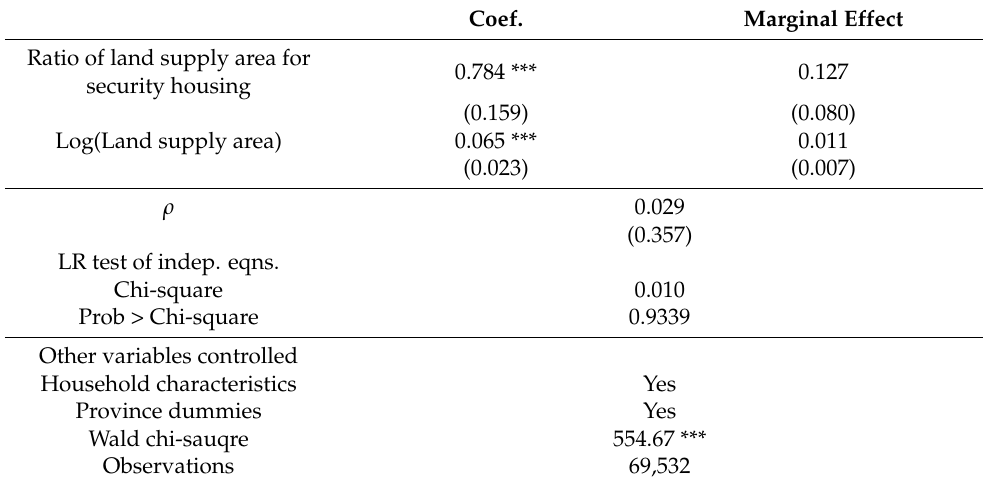
Table 6. Estimated results of housing security and settlement intention (Heckman probit model).